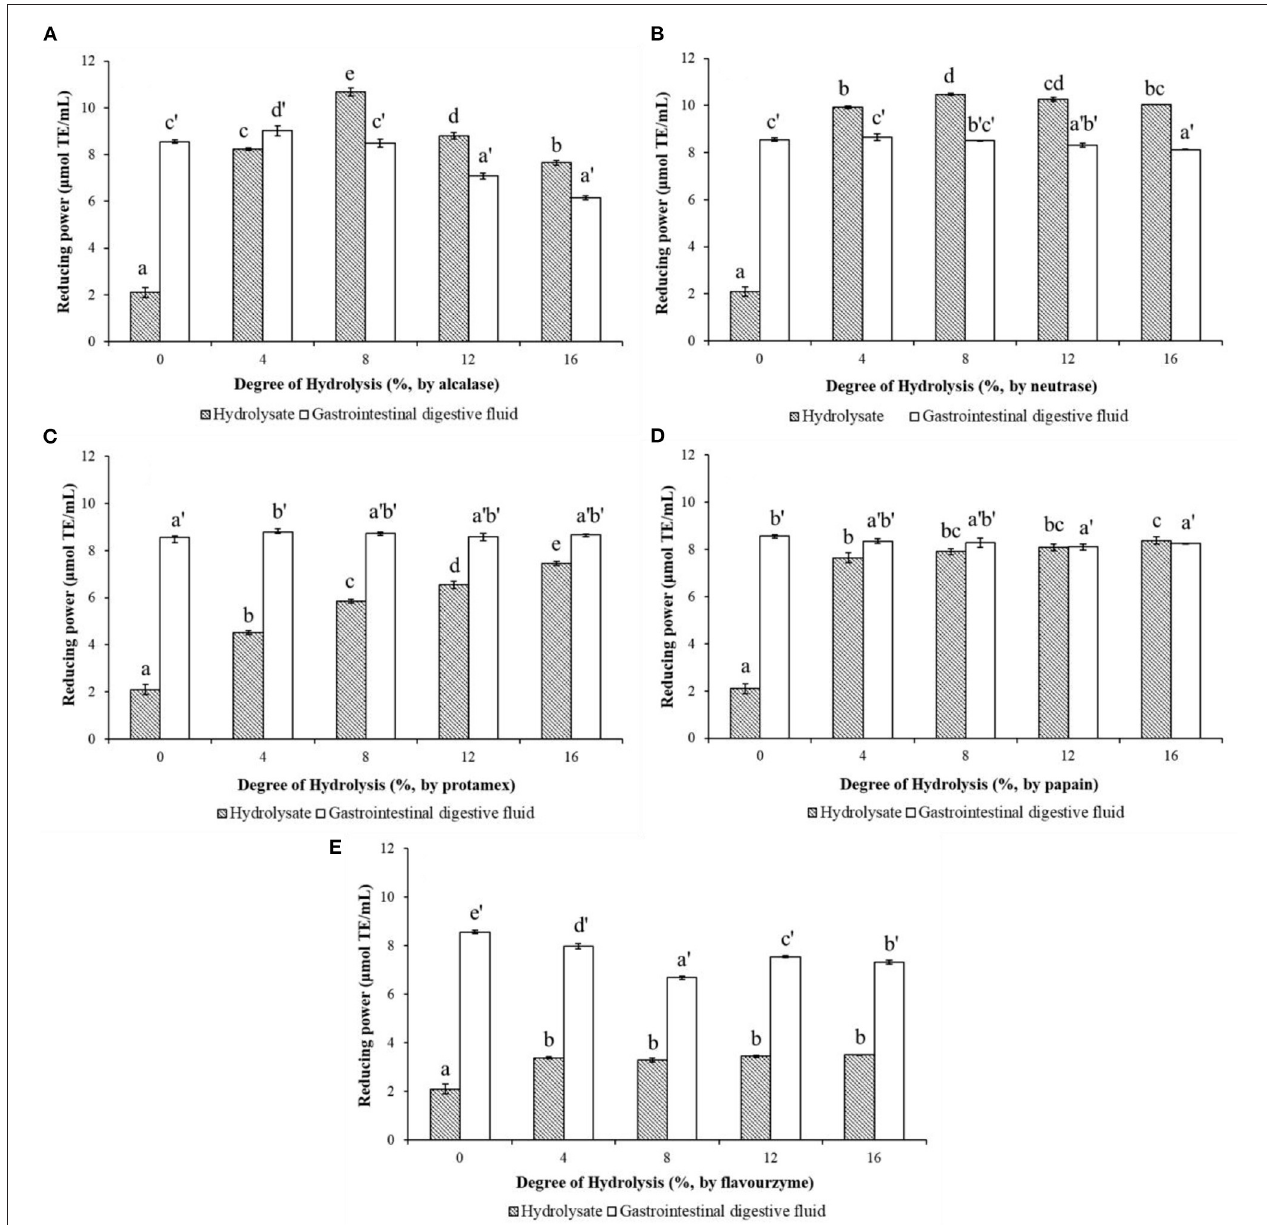
FIGURE 4 | Effects of the degree of hydrolysis (DH) of in vitro limited enzymolysis on the reducing power of walnut protein hydrolysates before and after the simulated gastrointestinal digestion in vitro . (A) Walnut protein hydrolysate produced by alcalase; (B) Walnut protein hydrolysate produced by neutrase; (C) Walnut protein hydrolysate produced by protamex; (D) Walnut protein hydrolysate produced by papain; (E) Walnut protein hydrolysate produced by flavourzyme. The results are expressed as mean ± SD ( n = 3). Means with different superscripts are significantly different ( p <